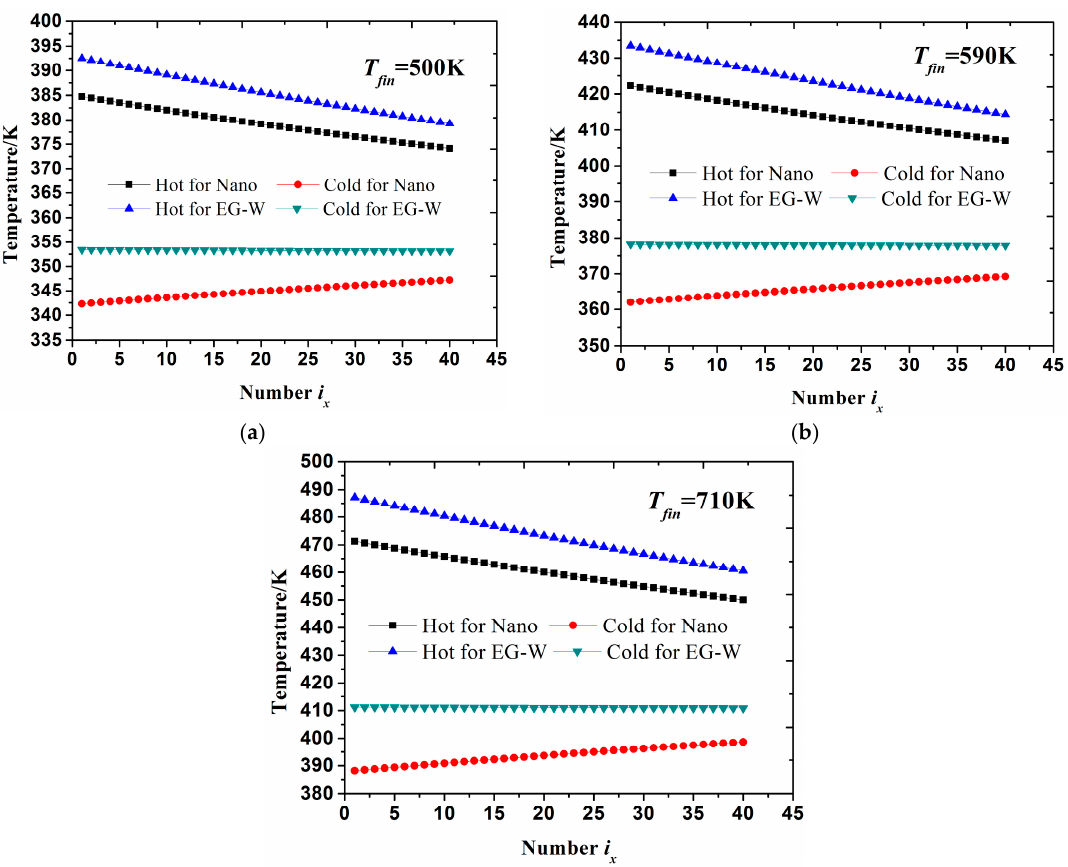
Figure 3. Temperature distributions of thermoelectric modules (TEMs) for two coolants under different inlet temperatures of exhaust: ( a ) T fin = 500 K; ( b ) T fin = 590 K; ( c ) T fin = 720 K.